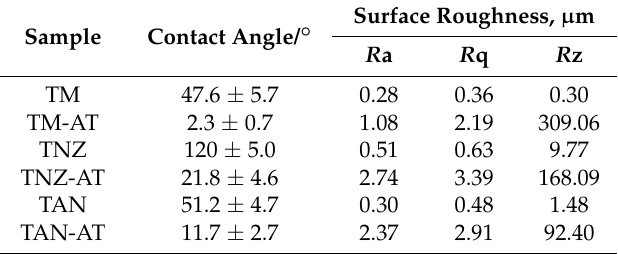
Table 2. The sample labels, wettability, surface roughness and 3D image of the investigated samples determined by an optical profilometer. (TM: Ti-15Mo; TNZ: Ti-13Nb-13Zr; TAN: Ti-6Al-7Nb; AT: Alkali